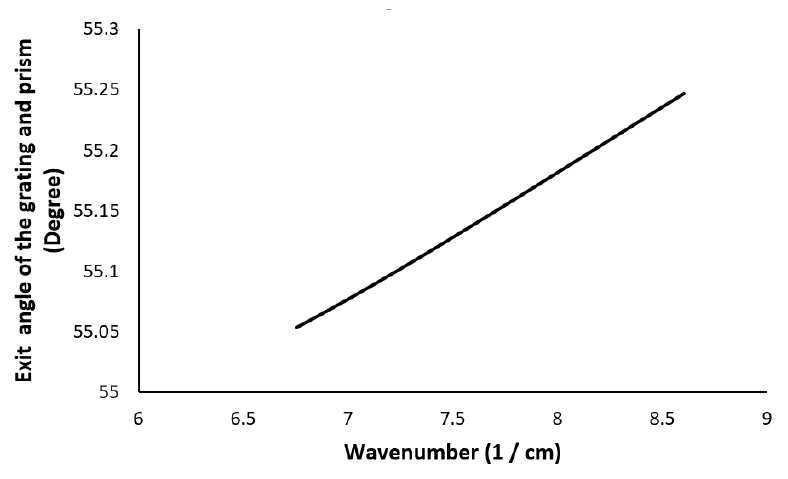
Figure 3. The angular variation of the exit angle for reflective grating and prism